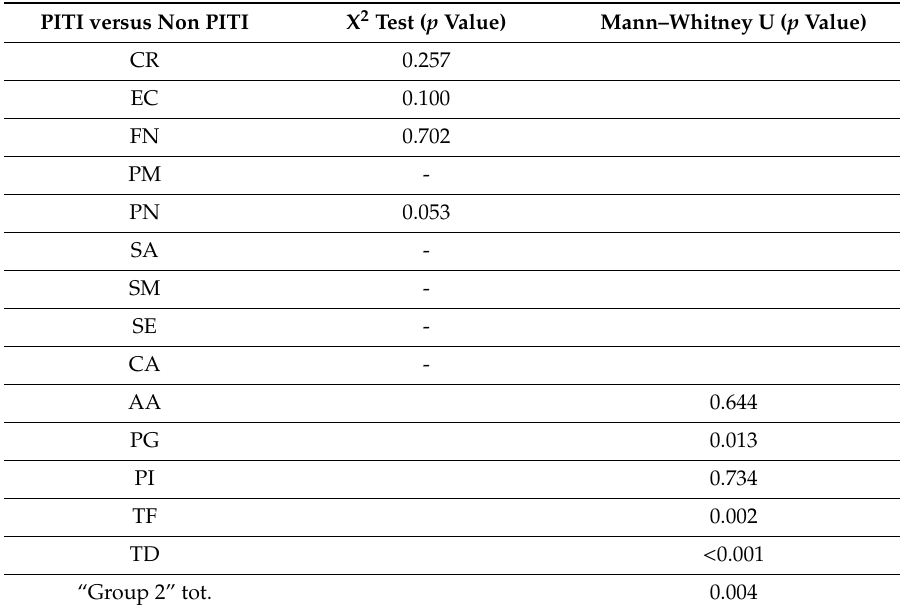
Table 5. Di ff erences in the microbial biofilms of implants with or without peri-implantitis (PITI) as evaluated in the CBP group (40 patients; 40 implants).